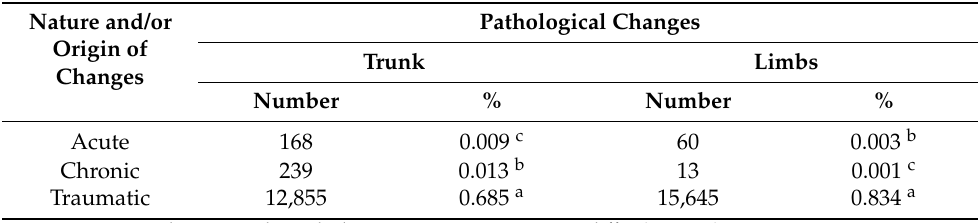
Table 3. The nature and/or origin of pathological changes on the trunk and limbs found in rabbits (n = 1,876,929) after slaughter at the slaughterhouse.